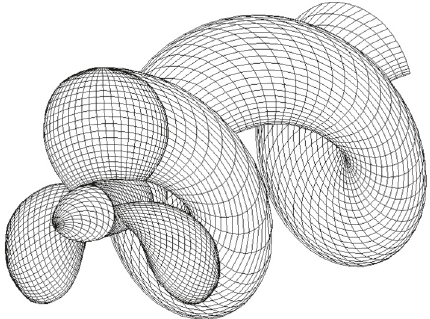
Figure 1: Panel arrangement of DTRC 4118 propeller.